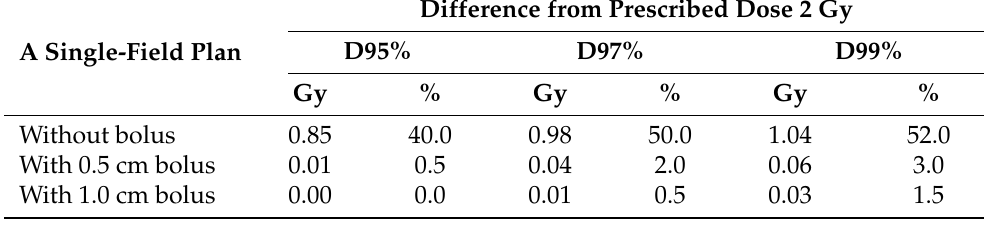
Table 3. Calculated difference between doses calculated by TPS and prescribed dose for single- field plan.